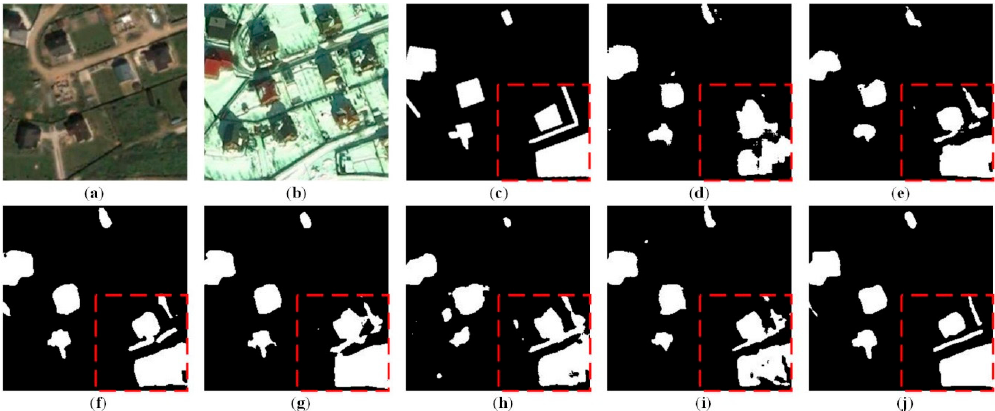
Figure 8. Visual comparisons of change detection results using di ff erent approaches for area 2: ( a ) image T 1 , ( b ) image T 2 , ( c ) reference change map, ( d ) CDNet, ( e ) FC-EF, ( f ) FC-Siam-conc, ( g ) FC-Siam-di ff , ( h ) FC-EF-Res, ( i ) FCN-PP, and ( j ) proposed method. The changed parts are marked in white while the unchanged parts are in black.